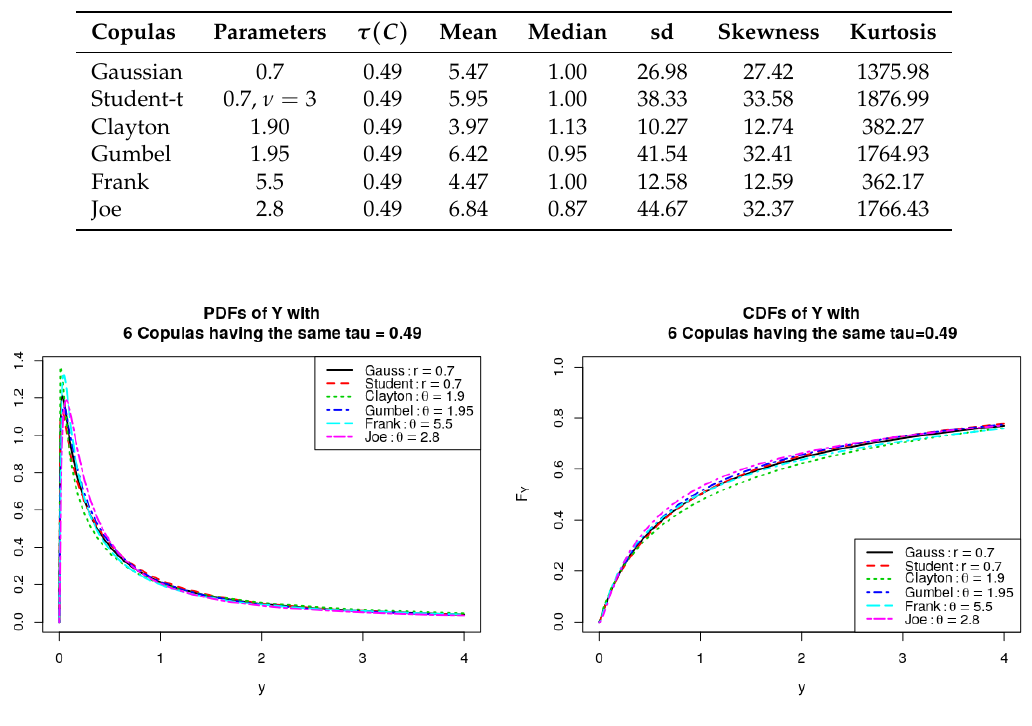
Figure 7. PDFs and CDFs of the product of two log-normal distributed random variables with six copulas having the same Kendall